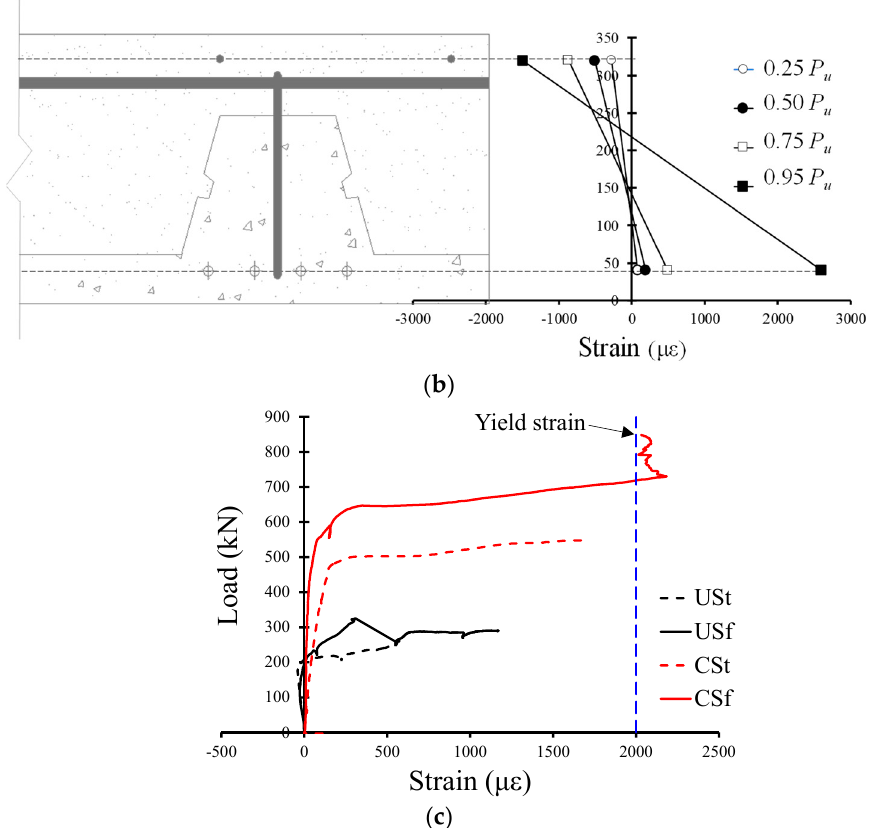
Figure 7. Measured strains from test specimens; ( a ) Strain distribution in the section located at maximum moment region (UF specimen); ( b ) Strain distribution in the section located at the maximum moment region (CF specimen); and ( c ) Stirrup strains measured from the shear test specimens.